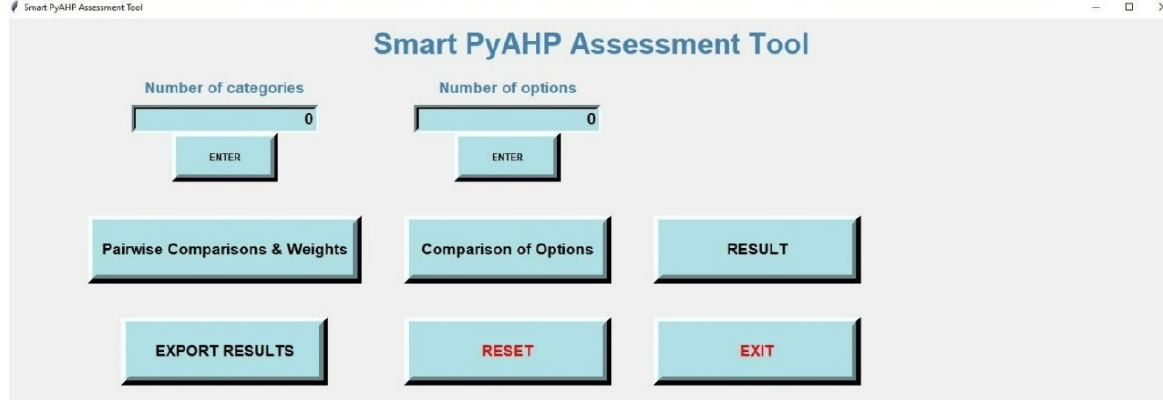
Figure 5. Main window of the computational tool.